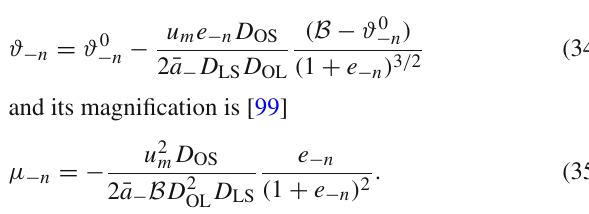
images, while Δ m + 1 , ∞ , Δ m − 1 , ∞ and Δ m + 1 , − 1 are respec-